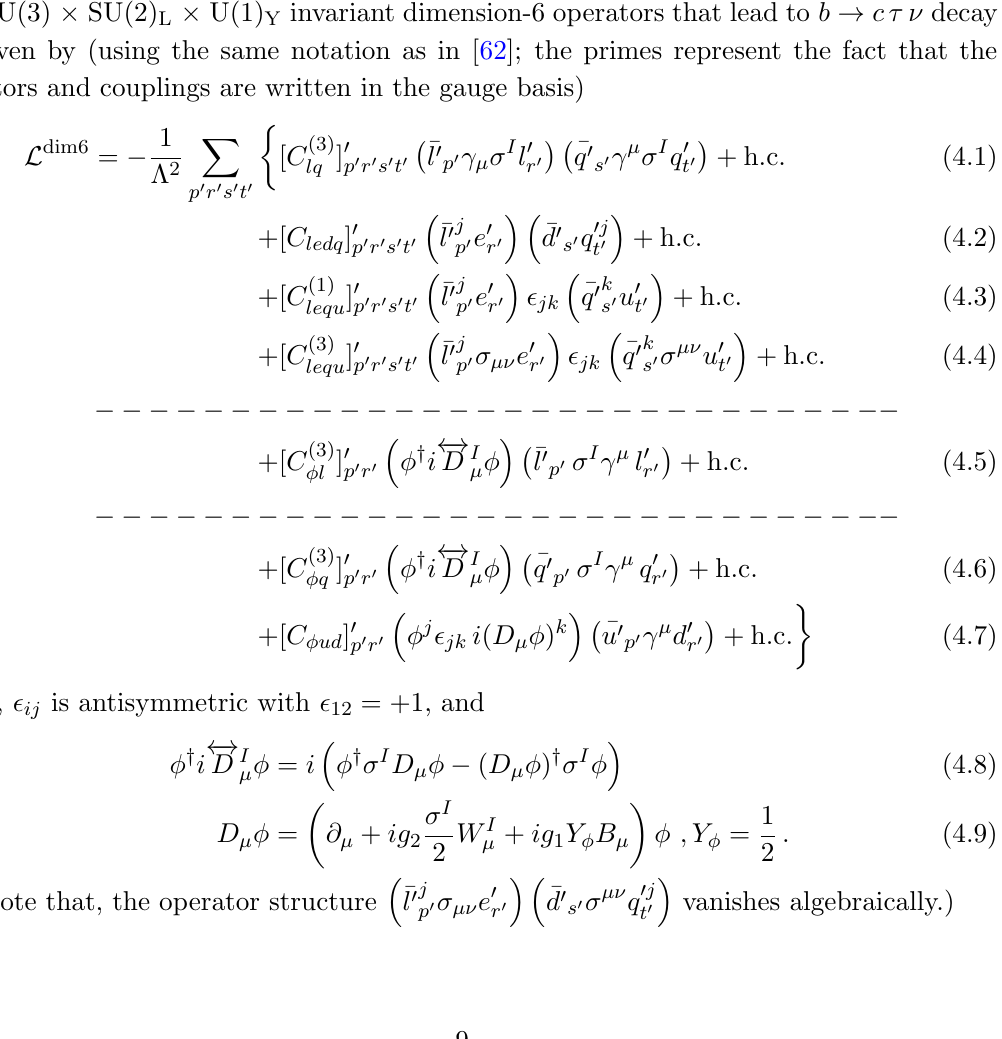
Figure 5 . Predictions for P (cid:28) ( D (cid:3) ), A FB ( D (cid:3) ) and R various simultaneous solutions of R D and R D (cid:3) anomalies. See text for more